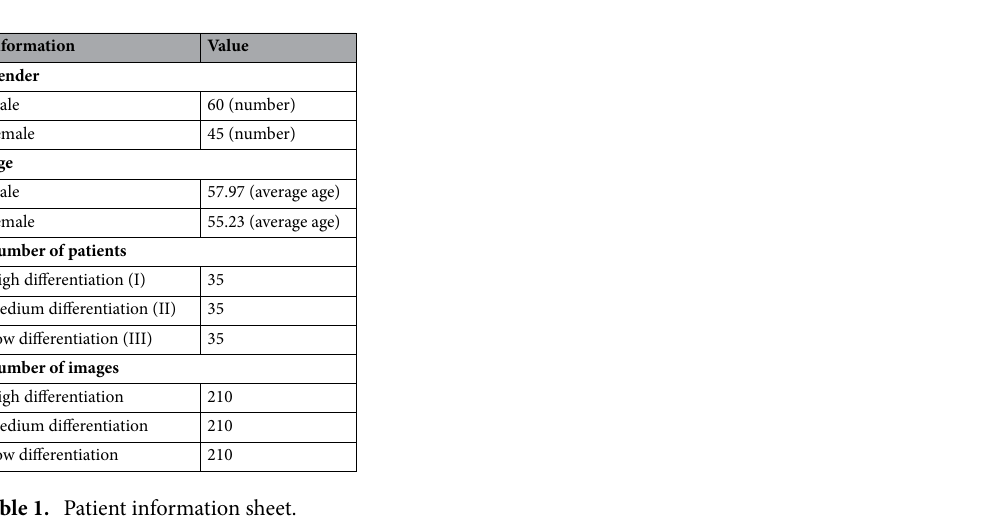
Figure 1. Different differentiation types of colorectal cancer by digital pathological imager at 40 times magnification. ( a ) Highly differentiated. ( b ) Moderately differentiated. ( c ) Highly differentiated.